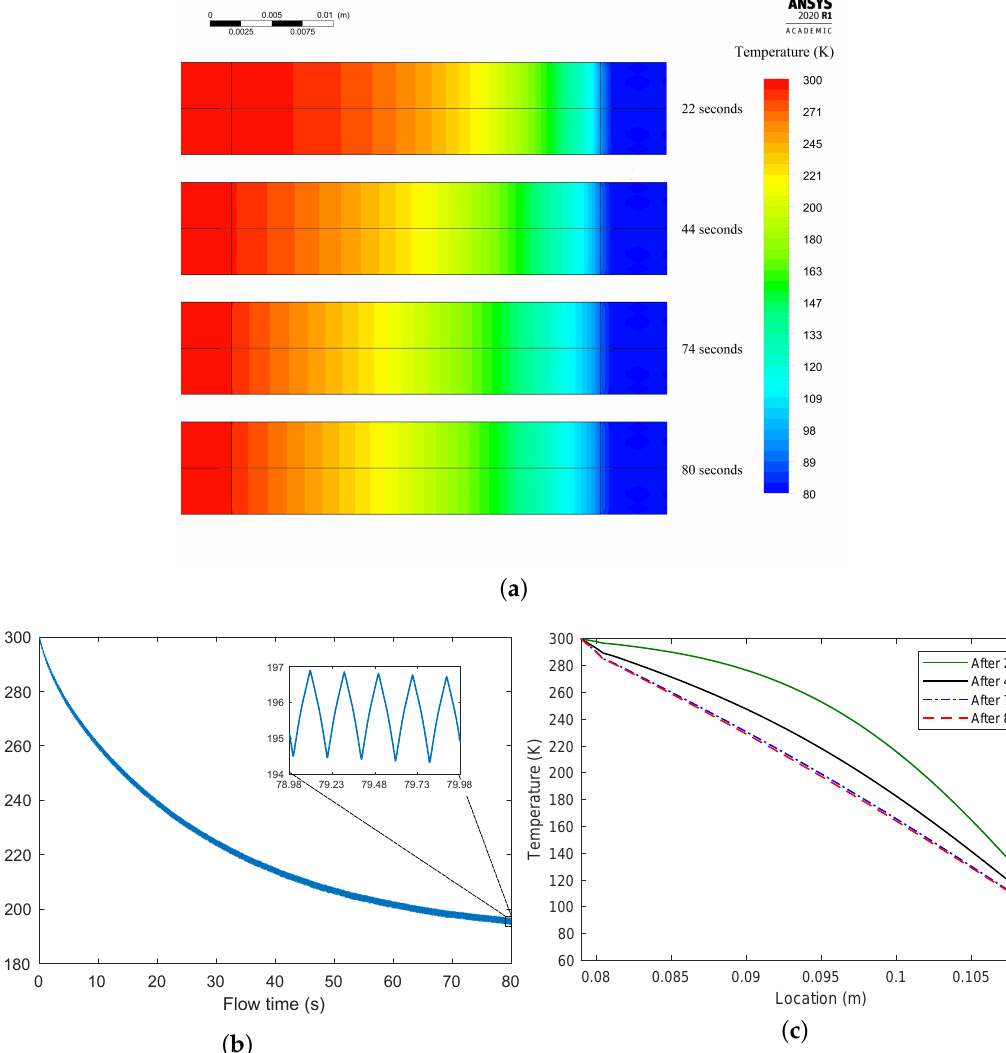
Figure 10. ( a ) Temperature contours after several flow times. ( b ) Average temperature versus flow time. ( c ) Temperature profiles across the regenerator’s center axis after different flow